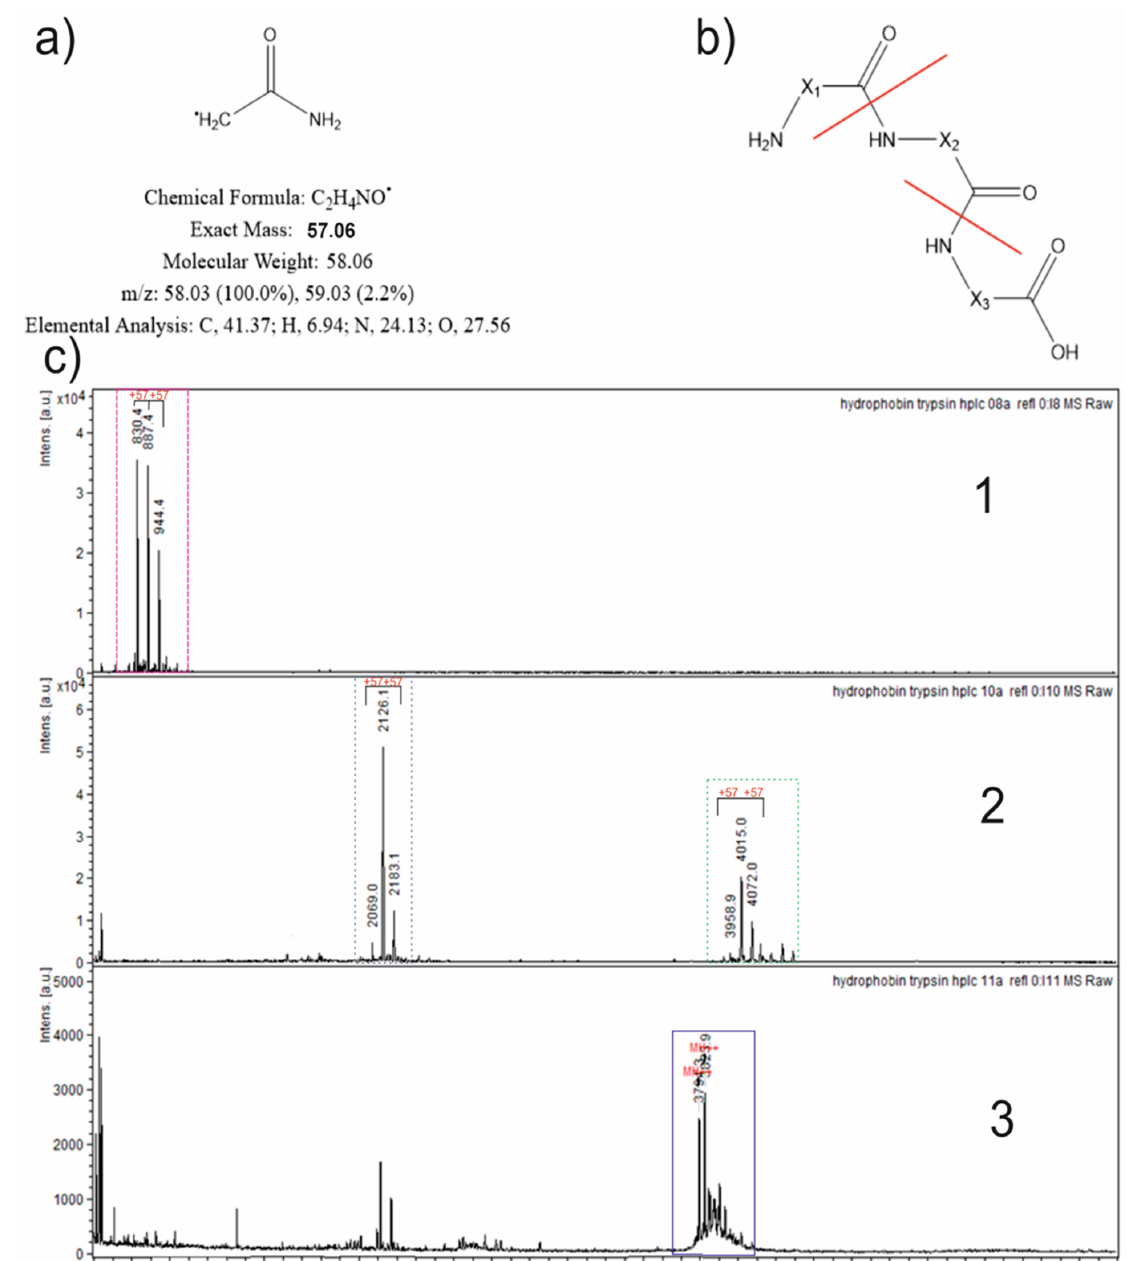
Figure 7. MALDI-TOF MS analysis of the collected fractions. ( a ) An acetamide radical as a modifying unit is presented with some physicochemical information. ( b ) The character of probable fragmentation in the MS|MS specters and the broken bonds are marked with red lines. ( c ) The mass specters of chromatographically collected fractions are presented. Peaks within every set that differ between each other by 57 Da (modifying unit) are marked with black lines and indexes “+57” above the peaks. For specters 1 and 2, the peak sets were highlighted in dotted rectangles colored in corresponding colors. The set in specter 3 is highlighted in a continuous rectangle as the mass of the unmodified hydrophobin.